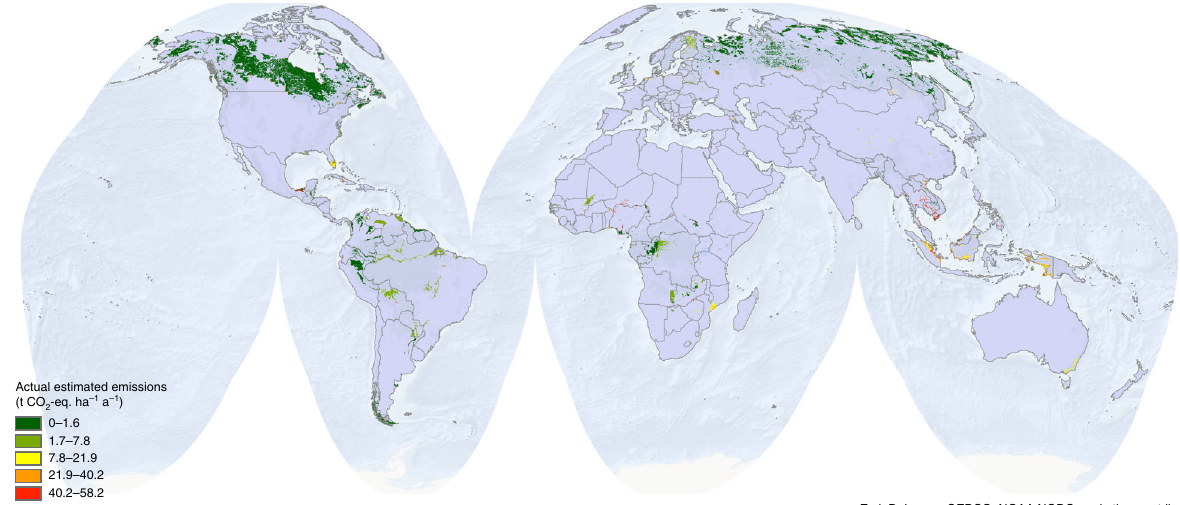
Fig. 2 Global peatland distribution and estimated annual actual emissions from peatland degradation. Data are calculated by correcting the potential emissions in Fig. 1 for the share of degraded peatland (see Supplementary Fig. 1), thereby highlighting regions with a large degree of disturbance. The map shows the average emission per area peatland for any given land use and climate category, not the average emission per area of disturbed peatland